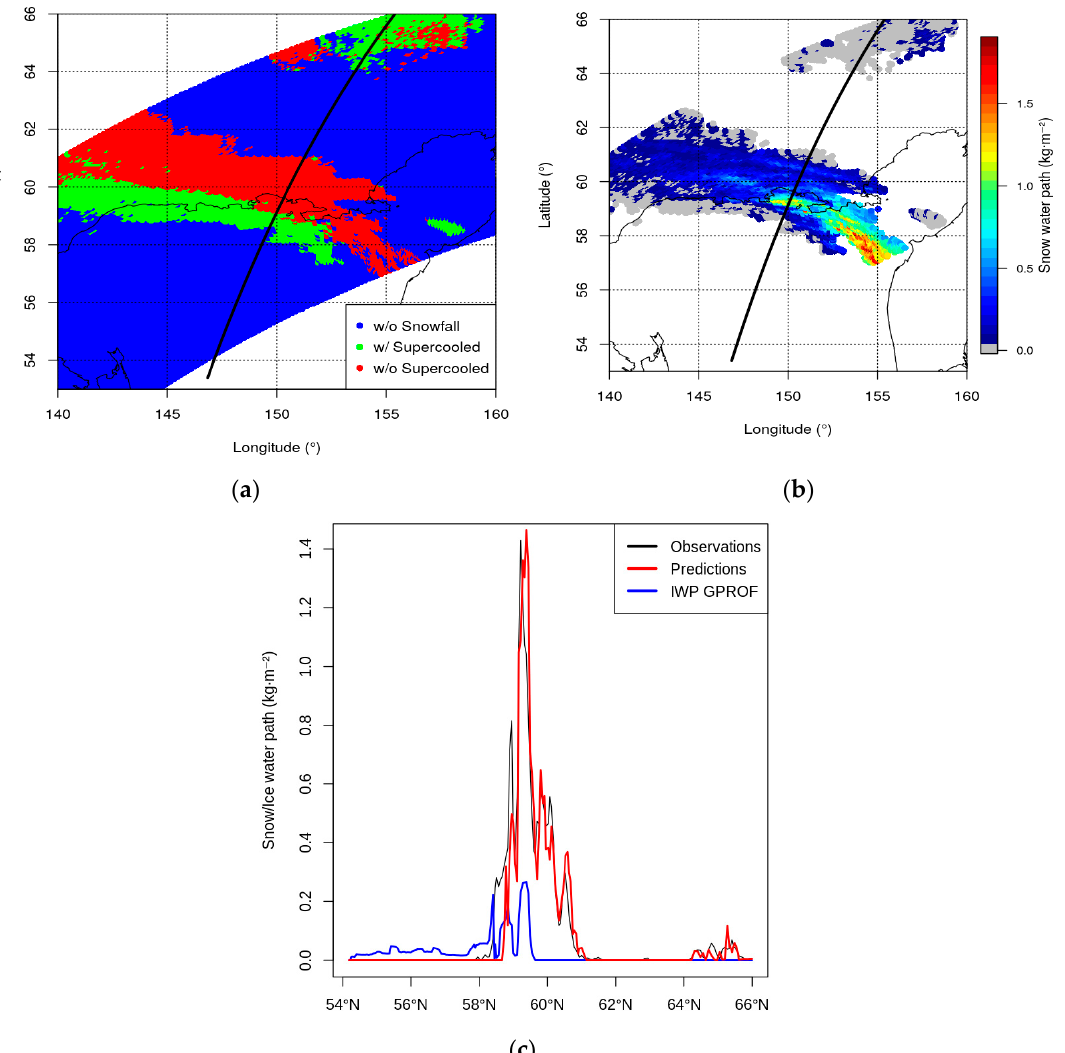
Figure 7. Case study of 30 April 2014: ( a ) Supercooled droplet classification, predicted by SLALOM (blue: Without snow; green: With snowfall and supercooled droplets; red: With snowfall and without supercooled droplets) and the CloudSat track in black; ( b ) retrieved SWP and the CloudSat track in black; and ( c ) SWP cross section along the CloudSat track for observations (black), SLALOM predictions (red), and the GPROF ice water path (IWP) (blue).